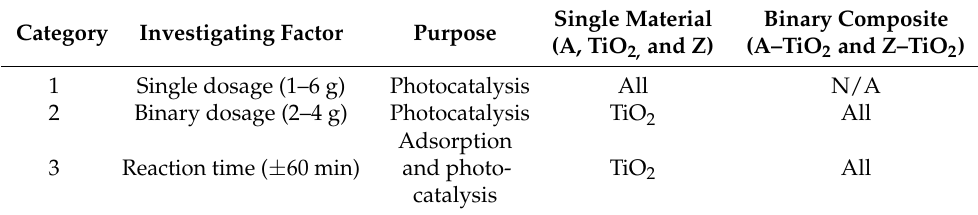
Table 3. Adsorption and photocatalysis experimental